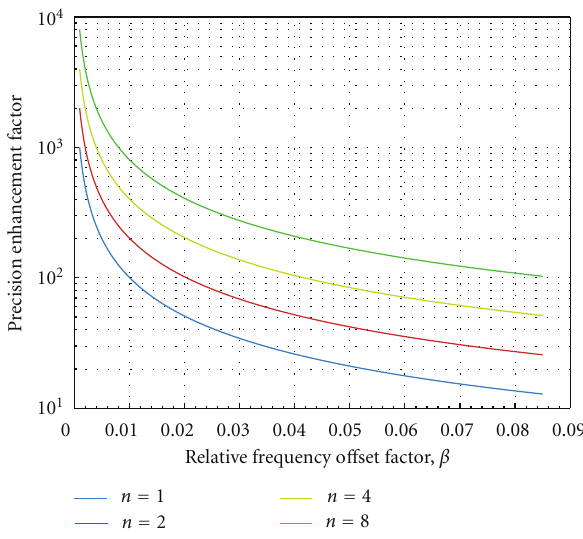
Figure 6: Dependency of the theoretical and the e ff ective precision enhancement on the relative frequency o ff set.